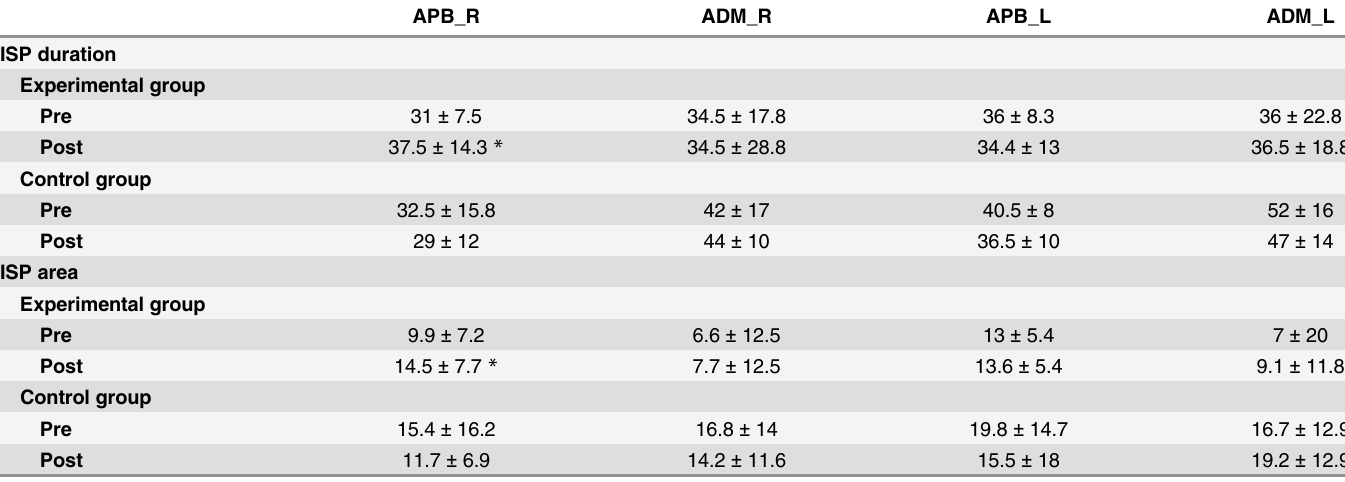
Table 3. ISP durations and areas (median ± interquartile range) in both groups in the pre and post conditions.